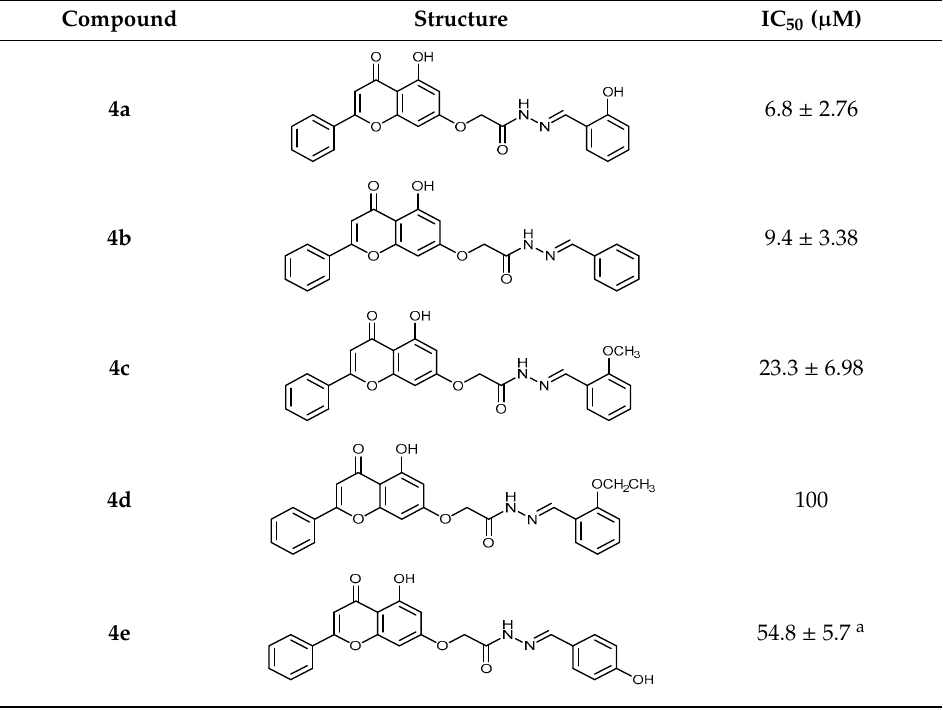
Table 2. The effects of chrysin derivatives ( 4a – 4o ) on the survival of the MDA-MB-231 cancer cell line. Compound